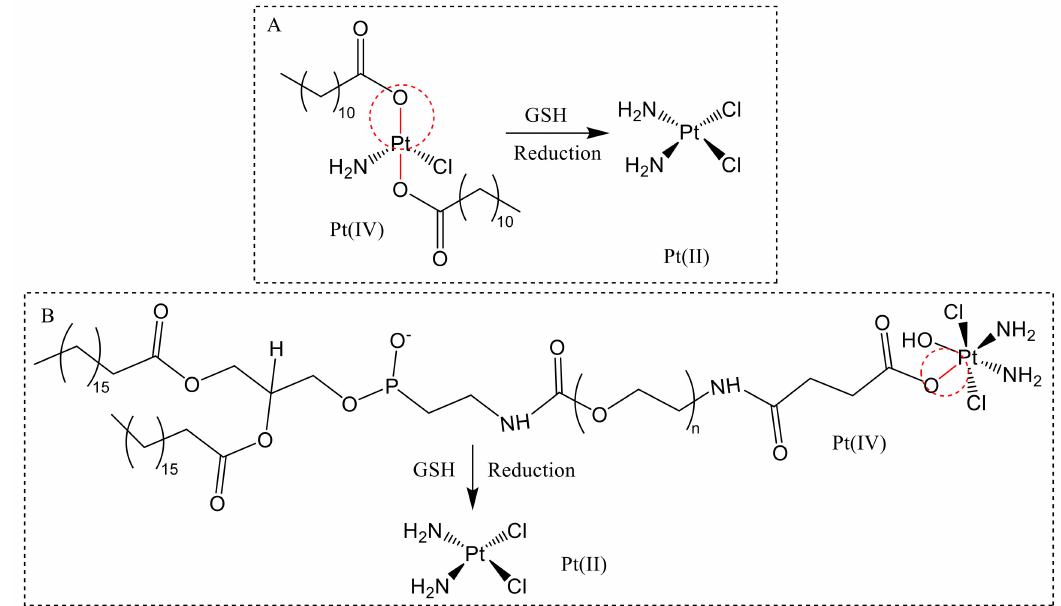
Figure 6. Self-assembled Pt (IV) nanoparticles for specific delivery of Pt drugs. ( A ) Pt (IV) was reduced with GSH to Pt (II) [76]. ( B ) Pt(IV)NP-cRGD was reduced with GSH to Pt (II)